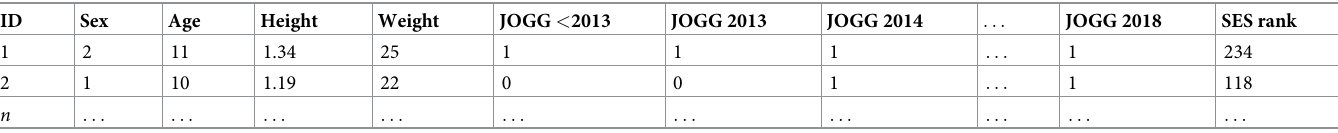
Table 2. Overview of the data frame’s